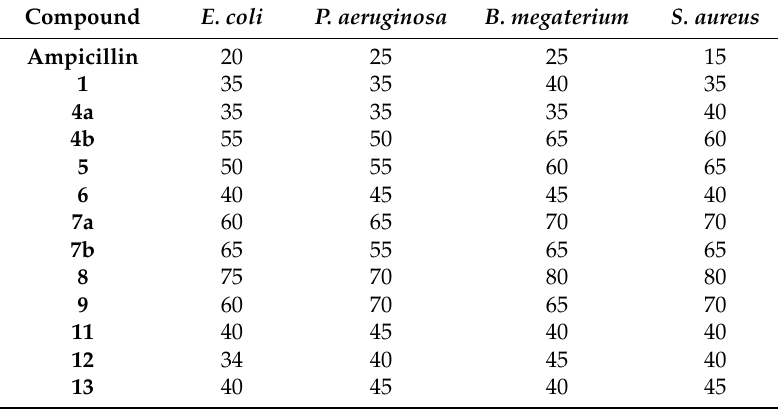
Table 3. Minimum inhibitory concentration (MIC) of novel compounds ( µ g/mL) against four microorganisms.